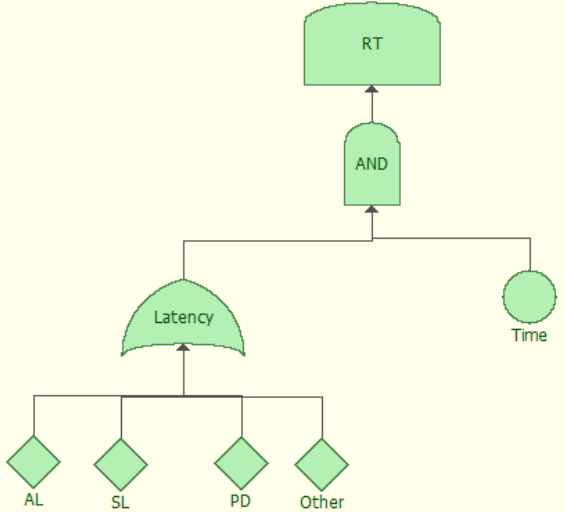
Figure 4. Real-time factors, second level fault tree diagram.